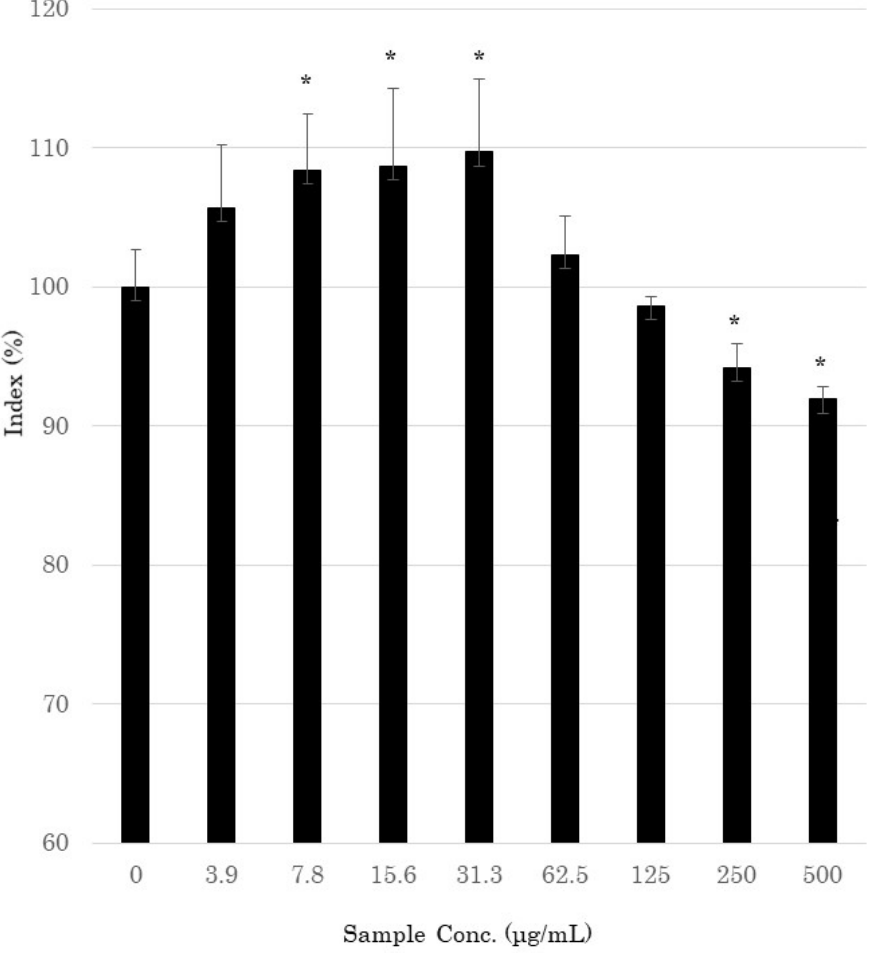
Figure 3. Cytotoxic effects of 2-aza-8-oxohypoxanthine (AOH) on normal human epidermal keratinocytes, as determined by the 3-(4,5-dimethylthiazol-2-yl)-2,5-diphenyltetrazolium bromide assay. The percent cell viability was calculated relative to the untreated control. * Significantly different from the control ( p < 0.05; Student’s t -test).